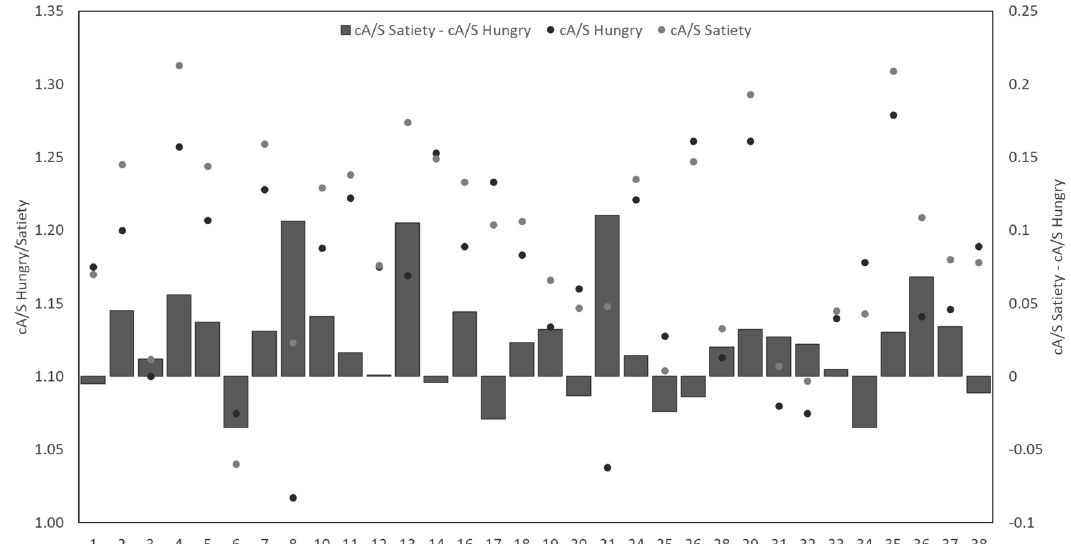
Figure 1. The subjects are plotted on the x-axis. On the left y-axis the absolute cA/S values are depicted for hungry (black circles) and satiated (grey circles). The subtraction of cA/S hungry from cA/S satiety is depicted on the right y-axis as bar chart. Positive values mean higher cA/S in the satiated condition compared to the hungry